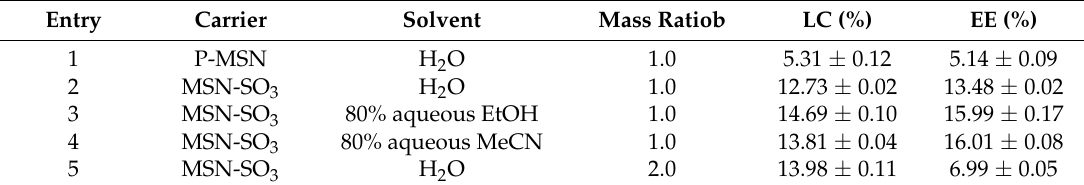
Table 2. Loading content (LC) and encapsulation efficiency (EE) of DQ into MSN-SO 3 nanoparticles a . Entry Carrier Solvent Mass Ratiob LC (%) EE